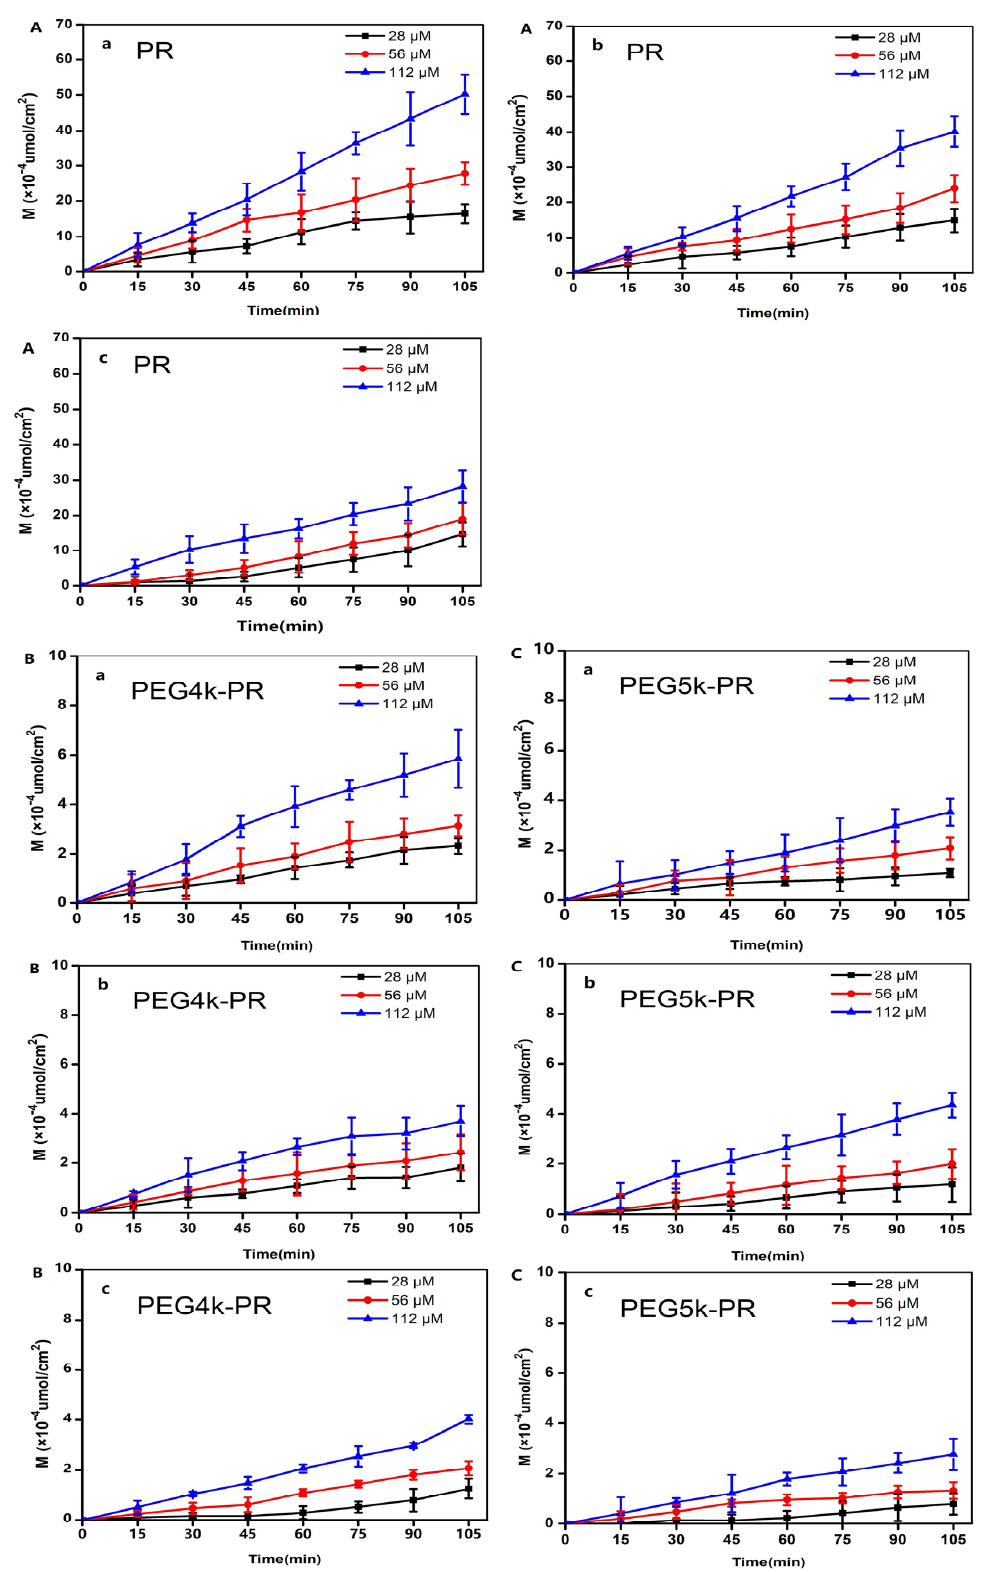
Figure 8. Cumulative intestinal permeable amount versus time of PR ( A ), PEG4k-PR ( B ), and PEG5k-PR ( C ) in the jejunum ( a ), ileum ( b ), and colon ( c ) at di ff erent concentrations (28–112 µ M). Data are shown as mean ± SD, n = 3.